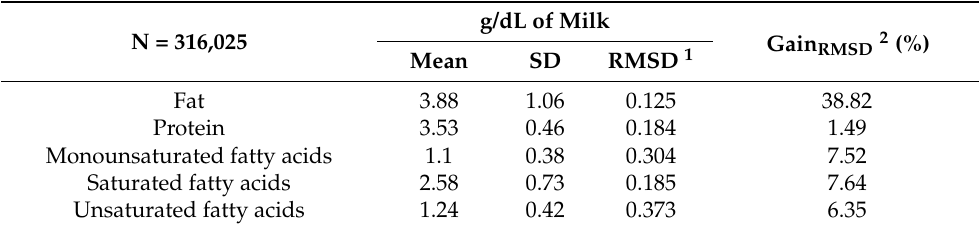
Table 6. Characteristics of the dataset obtained after a cleaning based on an absolute fat residual limitation set at 0.30 g/dL of milk (Method